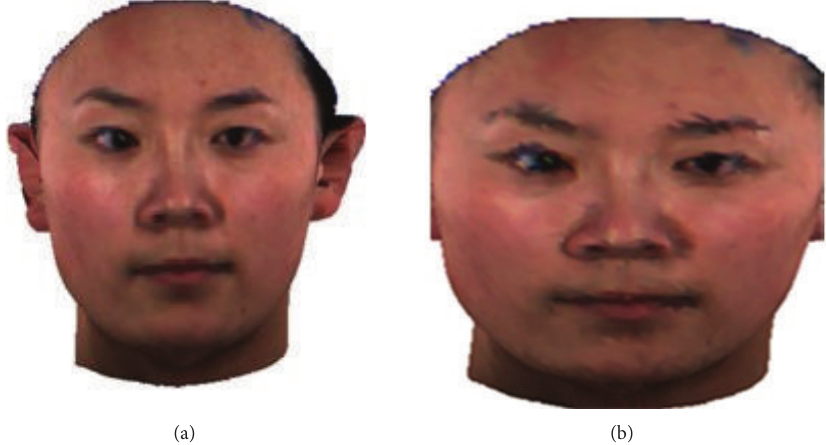
Figure 2: 3D face model (a) before mesh simplification and (b) after mesh